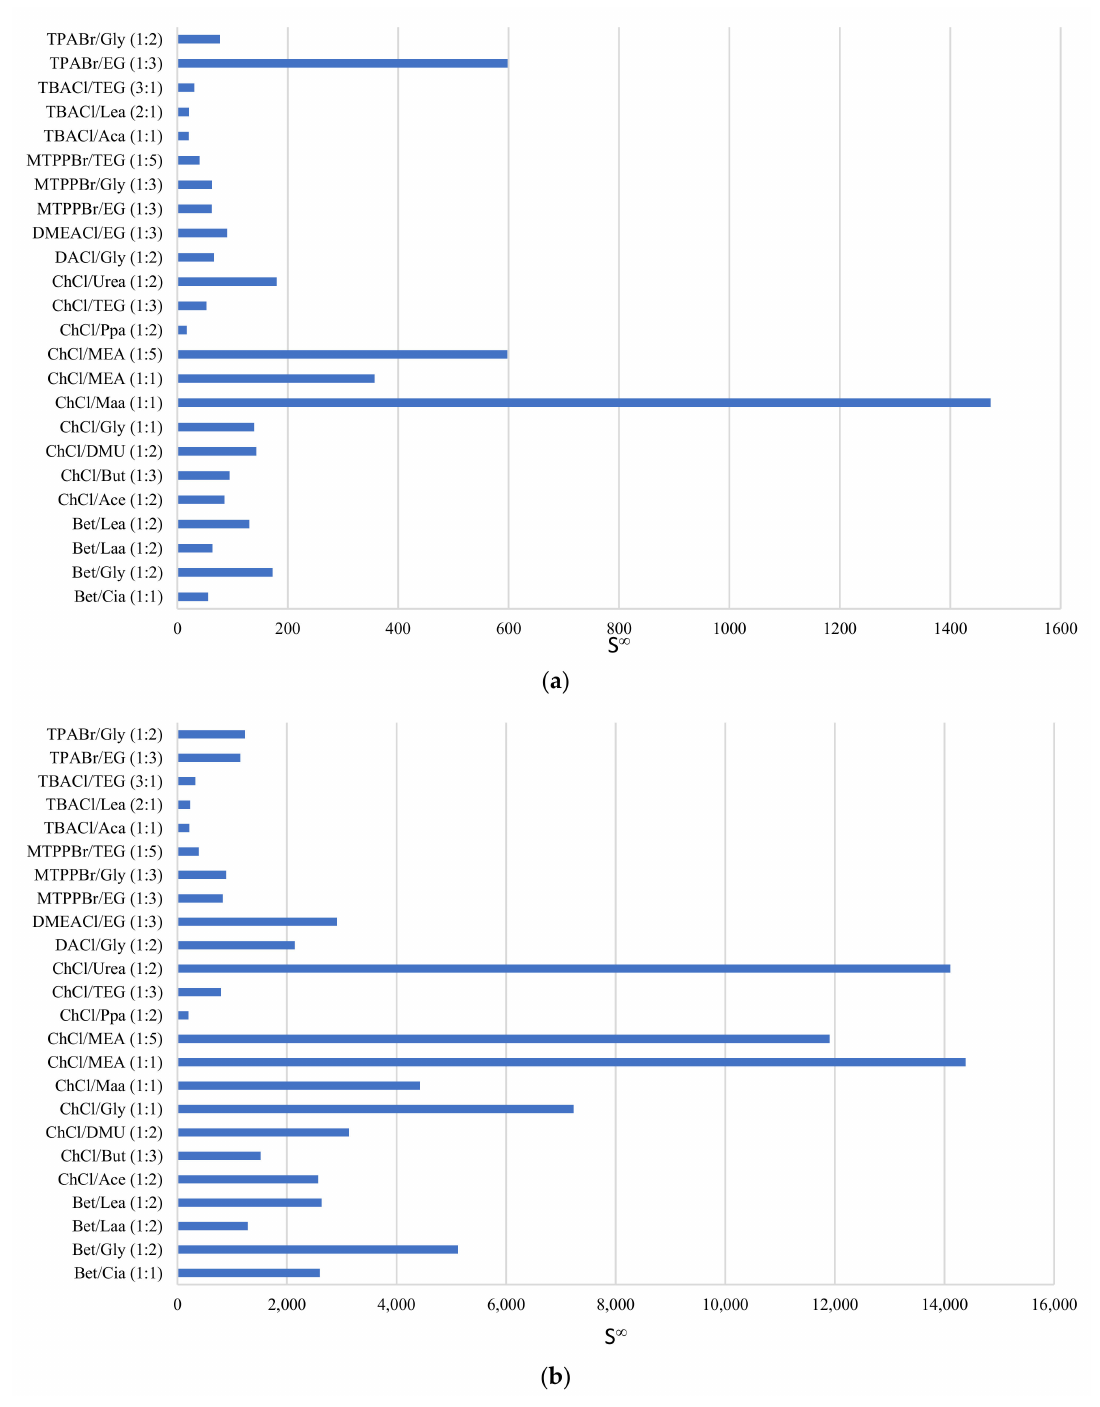
Figure 3. Selectivity of phenol in DESs using ( a ) toluene and ( b ) heptane as the model oil. Thereafter, the σ -profile and σ -potential of the selected DESs, MTPPBr/EG (1:3) and ChCl/MEA (1:5), towards model pyrolysis oil were generated. Figure 5 shows the σ -profiles of all the species involved in the system, where Figure 5a shows the σ -profile for the system ChCl/MEA (1:5), phenol, heptane, and toluene; and Figure 5b shows that for the system MTPPBr/EG (1:3), phenol, heptane, and toluene. In COSMO-RS, species with a narrow σ -profile correspond to low polarity, while species with a more broad range correspond to higher polarity [6]. From the figure, heptane shows a peak within the range of − 0.008 eA − 2 < σ < 0.008 eA − 2 , which lies in the non-polar region. This indicates the presence